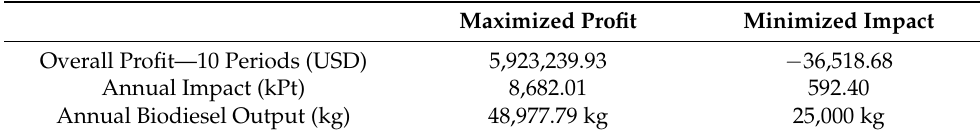
Table 2. Summary of single objective optimization